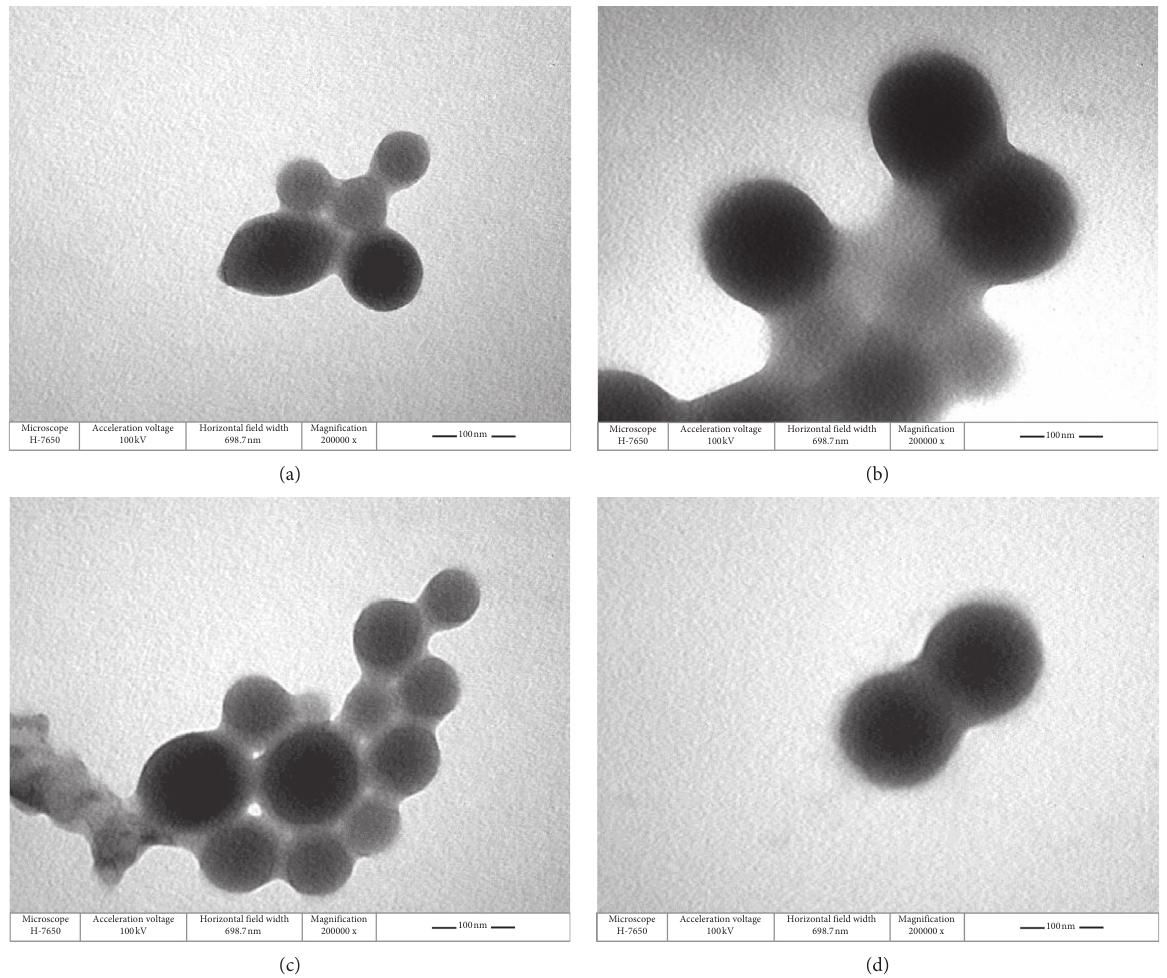
Figure 5: Transmission Electron Microscope (TEM) images of zein and lutein-loaded zein nanoparticle (LZN) (a, c), and zein hydrolysate nanoparticle and lutein-loaded zein hydrolysate nanoparticles (LZHN) (b, d).